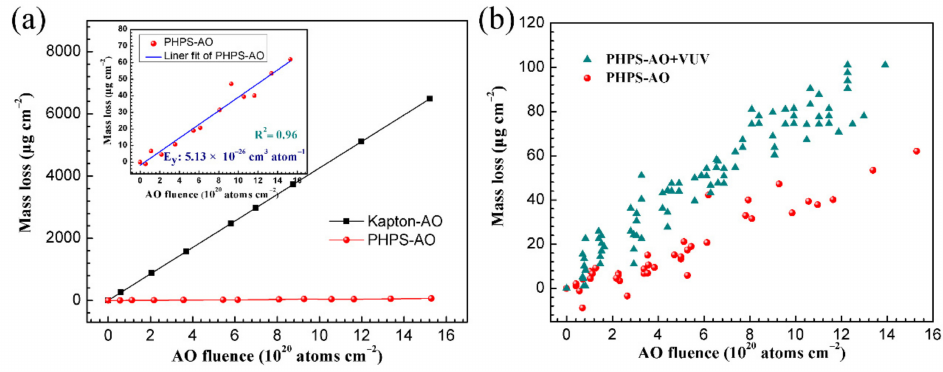
Figure 5. Dependence of the mass loss on the AO fluence for ( a ) prinstin and PHPS coated Kapton, that of the PHPS coated Kapton detailed in the inset figure and ( b ) PHPS coated Kapton after AO and AO + VUV exposure (Total fluence of AO exposure: 1.5 × 10 21 atoms cm − 2 , VUV intensity: 9.56 µ W cm − 2